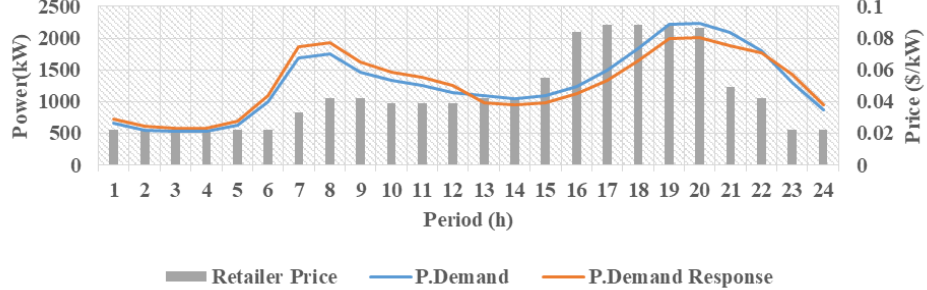
Figure 9. The demand response behavior of prosumer to the retailer pricing in a 10% demand response.